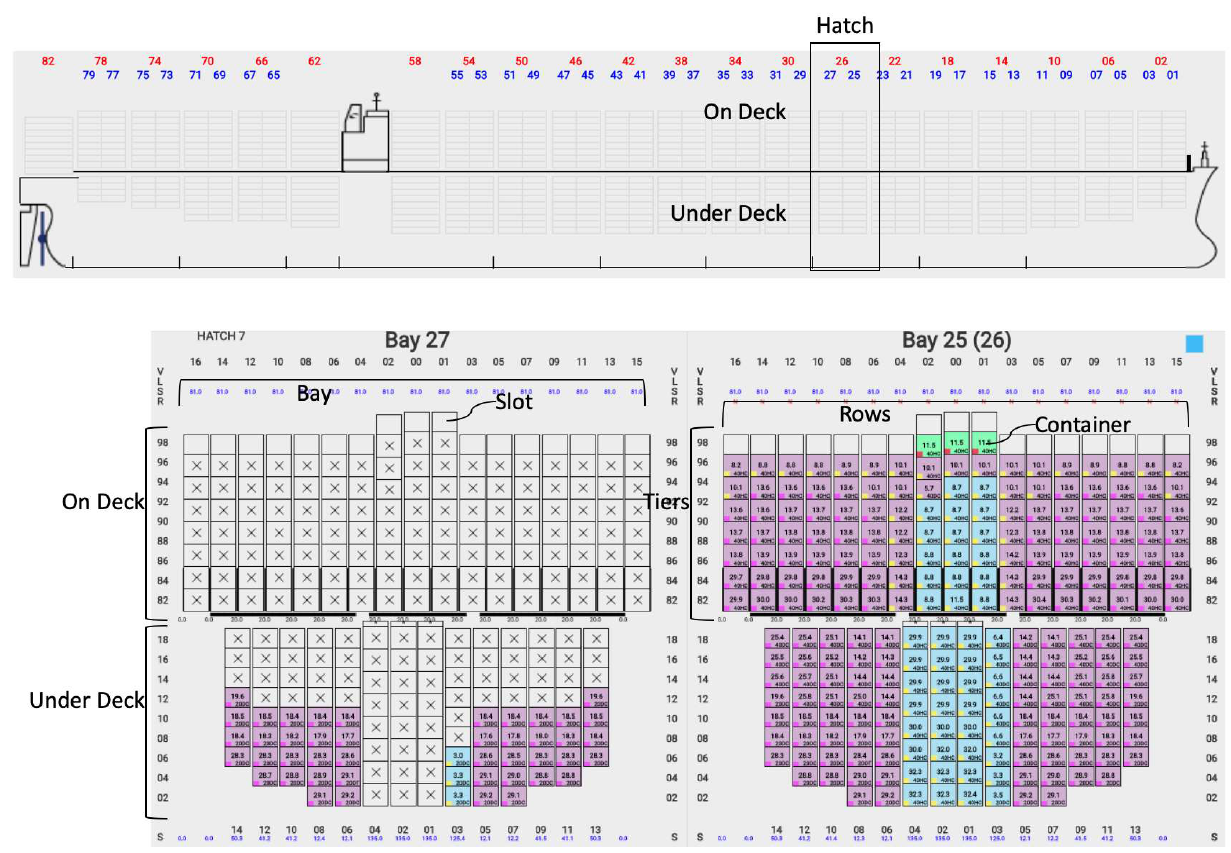
Figure 5. Presentation of containership structure in Bays.